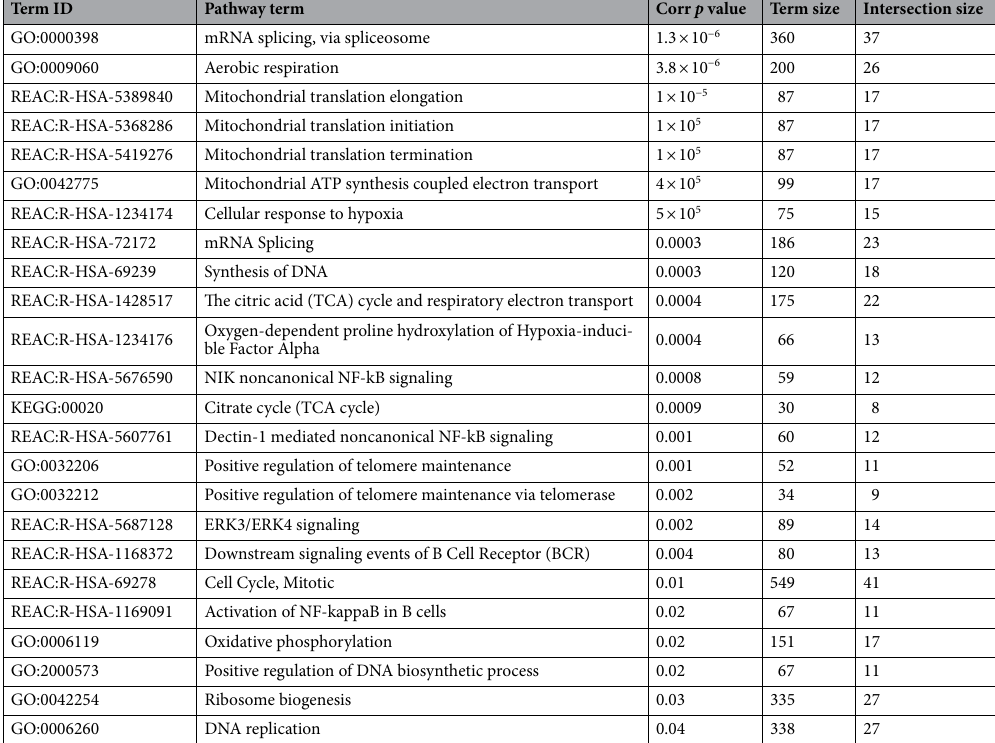
Table 1. Functional profiling of 649 genes that correlated with CSNK2A1 in CLL patients. Functional profiling analysis was conducted for the genes (n = 649) that correlated with CSNK2A1 in CLL patients (n = 130) using gProfiler (https:// biit. cs. ut. ee/ gprofi ler/ gost) against gene ontology database (http:// geneo ntolo gy. org/) 65,66 , KEGG pathway database (https:// www. genome. jp/ kegg/) 67 , Reactome pathways database (https:// react ome. org/) 68 and WikiPathways database (https:// www. wikip athwa ys. org/ index. php/ WikiP athwa ys) 69 . Corr p value, corrected p value that was calculated on the basis of Benjamini–Hochberg false discovery rate (FDR). Term size, number of all genes that have been known to function in a pathway term. Intersection size, number